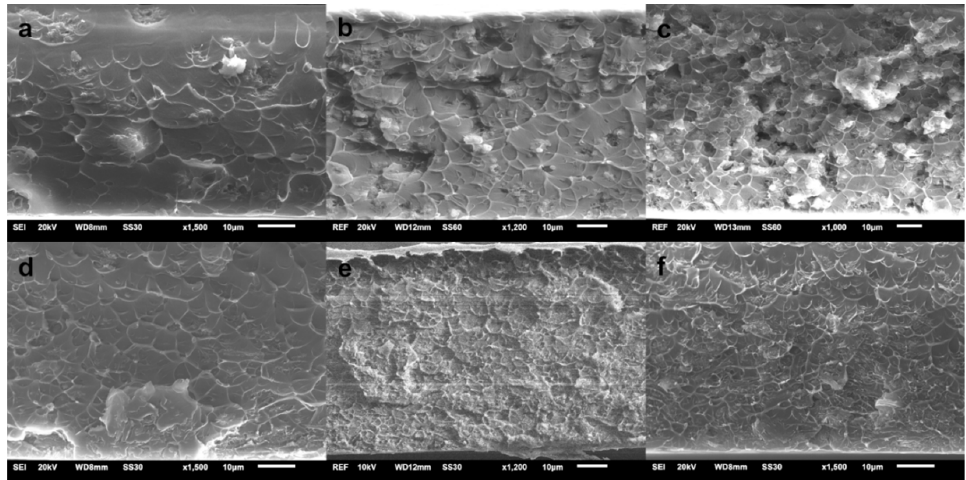
Figure 7. Cross-section SEM images of HHU-COF-1/Matrimid with ( a ) 8 wt%, ( b ) 16 wt%, and ( c ) 24 wt% filler and HHU-COF-2/Matrimid MMMs with ( d ) 8 wt%, ( e ) 16 wt%, and ( f ) 24 wt% filler.